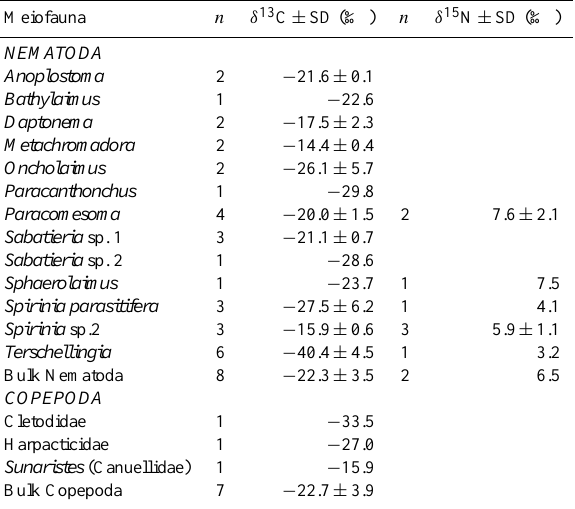
Table 2. Mean ( ± SD) stable isotope signatures of meiofauna from the deeper sediment layers (2–6cm), from all stations ( n = number of replicate